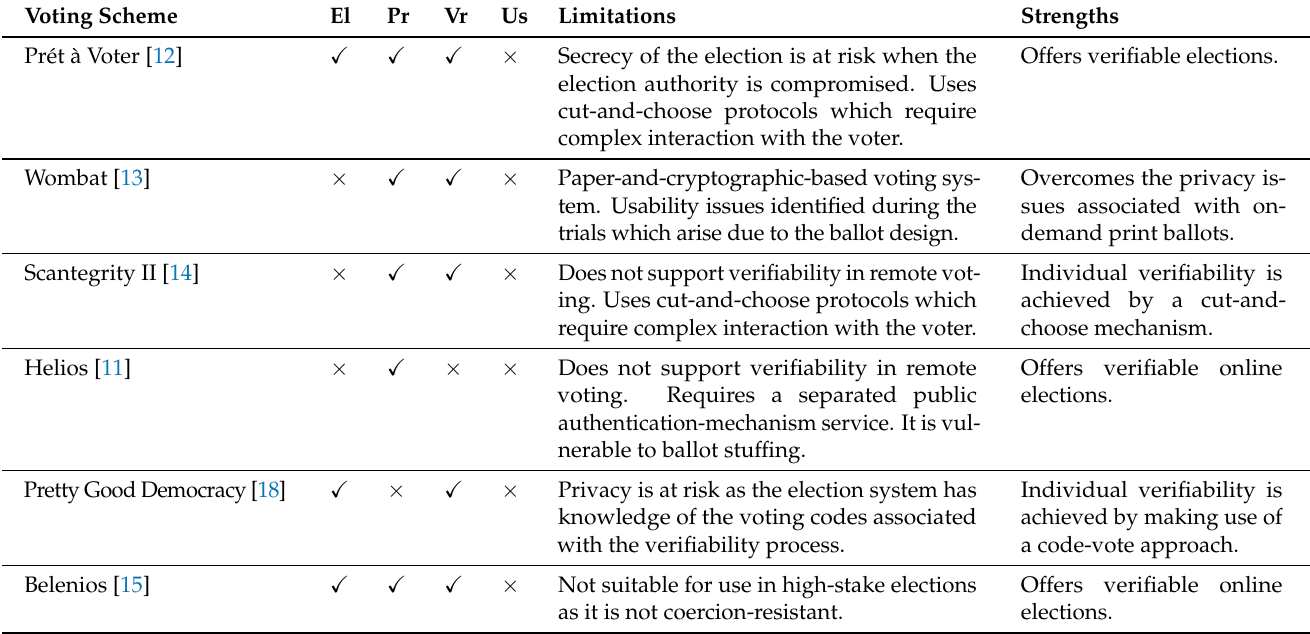
Table 1. Motivating the need for PVPBC by comparing the strengths and shortcomings of existing e-voting systems under the headings: Eligibility (El), Privacy (Pr), Verifiability (Vr) and Usability